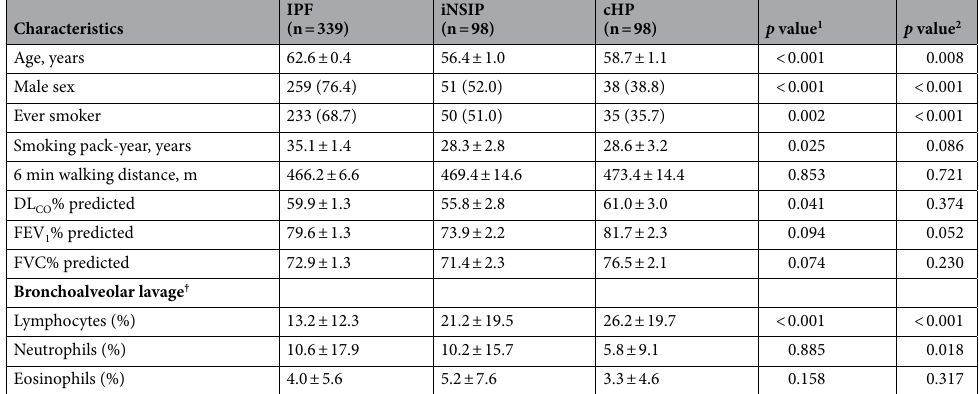
Table 1. Demographic and clinical characteristics of patients assorted by diagnostic categories. Data are presented as mean ± standard devation or number (%). UIP, usual interstitial pneumonia; iNSIP, idiopathic nonspecific interstitial pneumonia; cHP, chronic hypersensitivity pneumonitis; DL CO , diffusing capacity of the lung for carbon monoxide; FEV 1 , forced expiratory volume in 1 s; FVC, forced vital capacity. 1 UIP vs iNSIP; 2 UIP vs cHP. † Analysed in 220 patients with UIP, 65 patients with iNSIP and 86 patients with cHP.